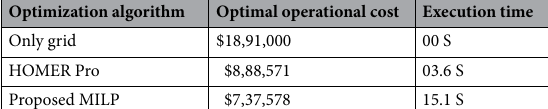
Table 9. Comparison of Different Optimization